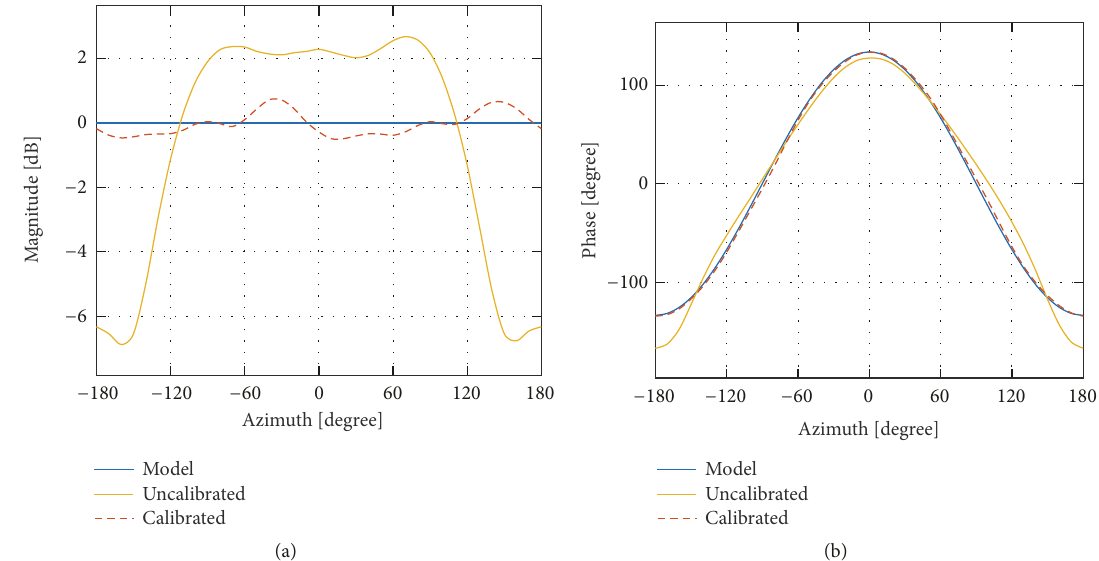
Figure 4: Measured response of the first sensor of the Poynting DF-A0046 UCA, the corresponding response of the element-space model and the sensor response after calibration with the calibration matrix estimated by the method of Wax. The plots show the (a) magnitude and (b) phase of the response.